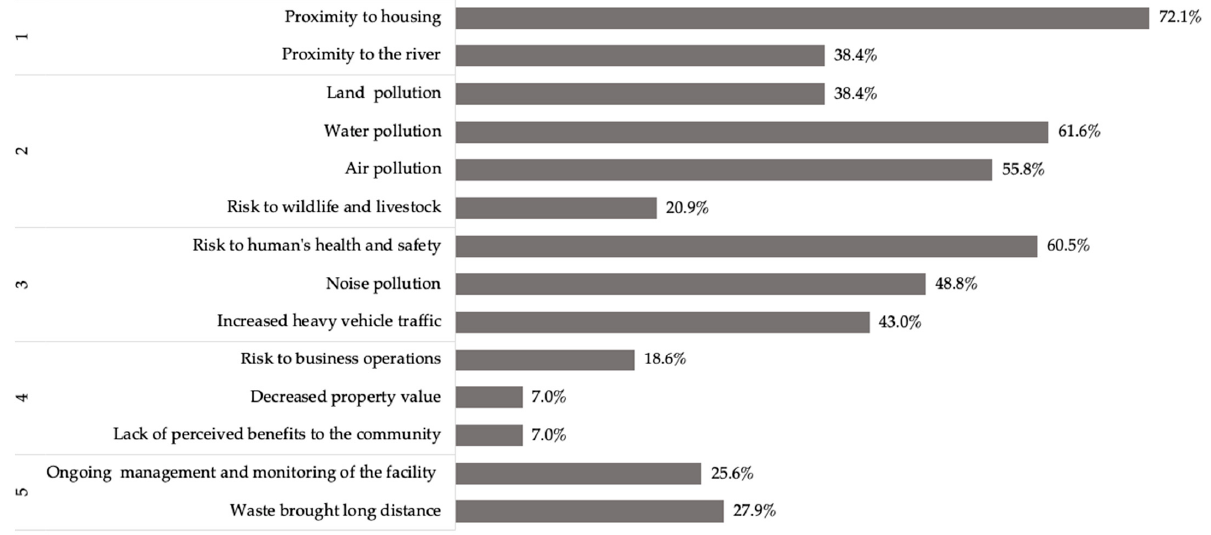
Figure 3. Percentage of perceived risk categories. Source: authors.